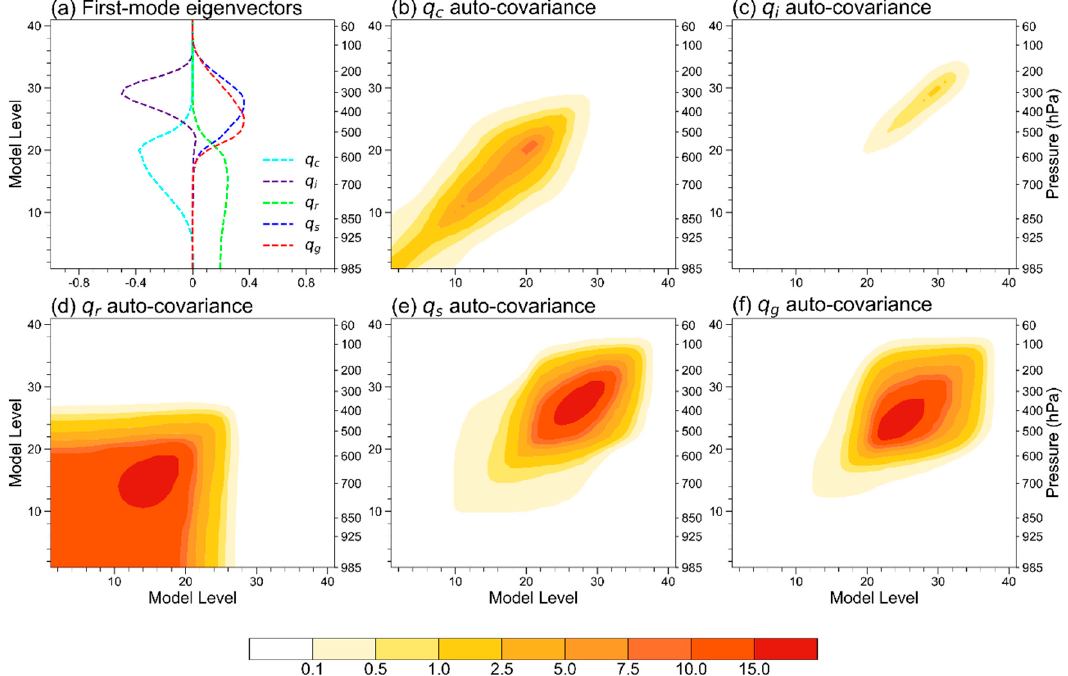
Figure 1. Vertical eigenvectors and vertical auto-covariance of hydrometeors. ( a ) First-mode eigenvector of hydrometeors, the horizontal axis is eigenvector value. ( b – f ) The vertical auto-covariance (units: 10 − 9 kg 2 /kg 2 ) of ( b ) q c , ( c ) q i , ( d ) q r , ( e ) q s and ( f ) q g , the horizontal axis is model level. The left vertical axis is model level, and the right vertical axis is the pressure level (units: hPa).